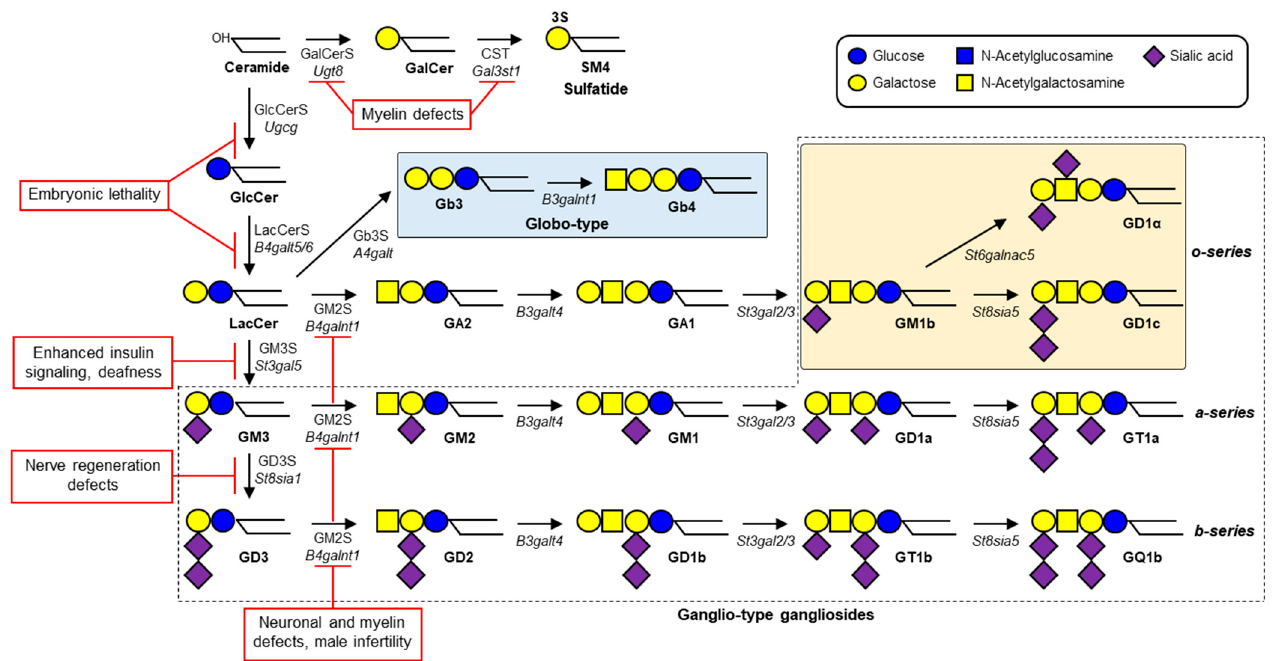
Figure 1. Biosynthetic pathway of gangliosides and sulfatide. GlcCerS catalyzes with the addition of glucose to ceramide, and LacCerS subsequently adds galactose to GlcCer to form LacCer. GalCerS catalyzes with the addition of galactose to ceramide to form GalCer, and CST subsequently adds a sulfate group to form sulfatide SM4. Red rectangles indicate phenotypes observed in mouse KO models. Expression of globo-type GSLs (highlighted by blue rectangle) is elevated substantially in fibroblasts of human GM3S-deficiency patients. In contrast, in GM3S KO-mouse brains and fibroblasts, expression of globo-type GSLs is only slightly elevated, but that of o-series gangliosides (GM1b, GD1 α , GD1c: highlighted by yellow rectangle) is elevated substantially (see main text).